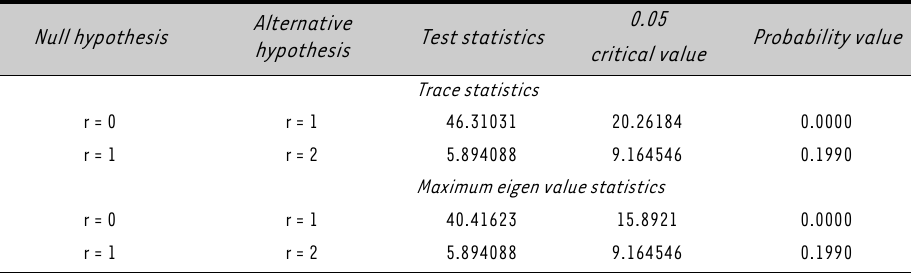
Cointegration test results between LNGDP and